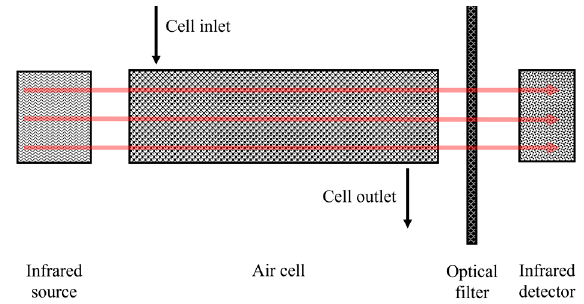
Figure 1. Diagram of an NDIR-type sensor operation based on [36].